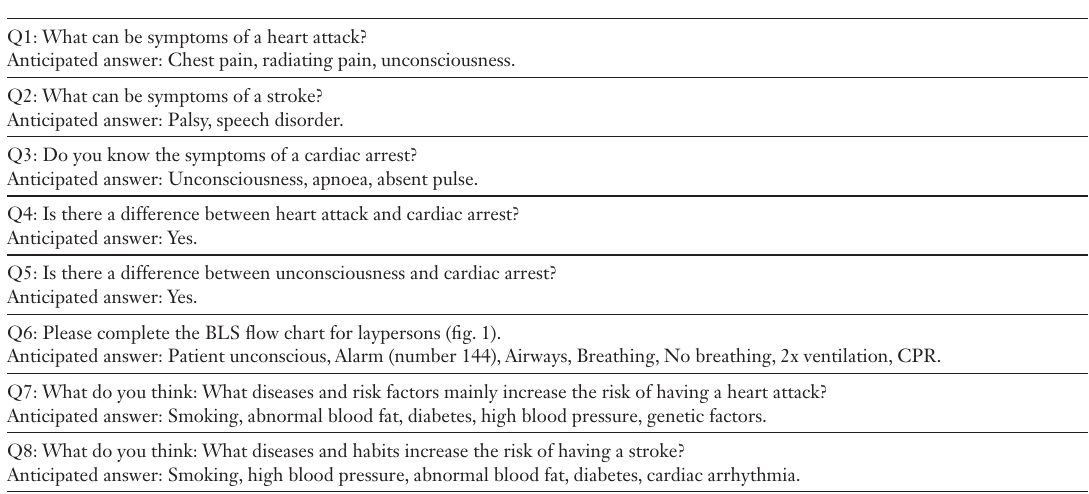
Figure 1 BLS flow chart for laypersons according to AHA guidelines 2005 to complete (Question